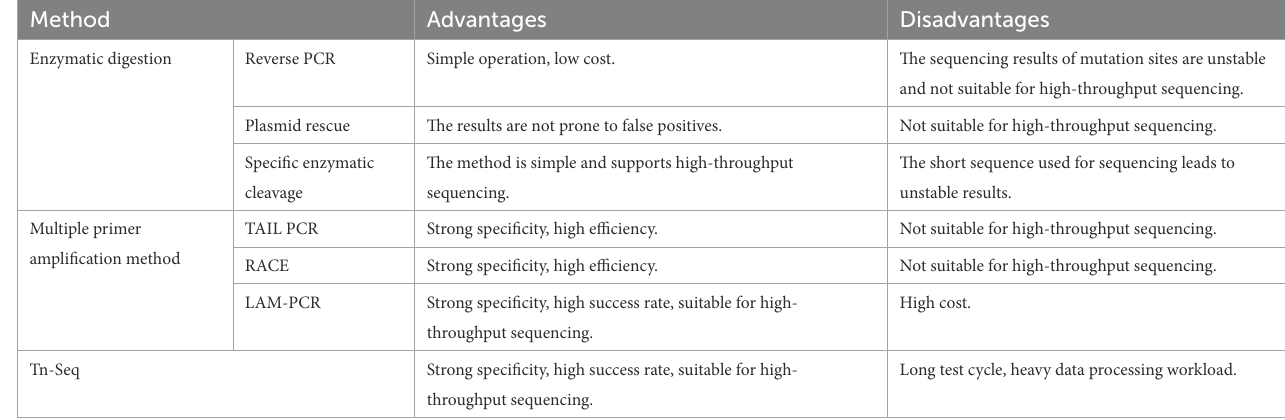
TABLE 2 Comparison of sequencing methods.